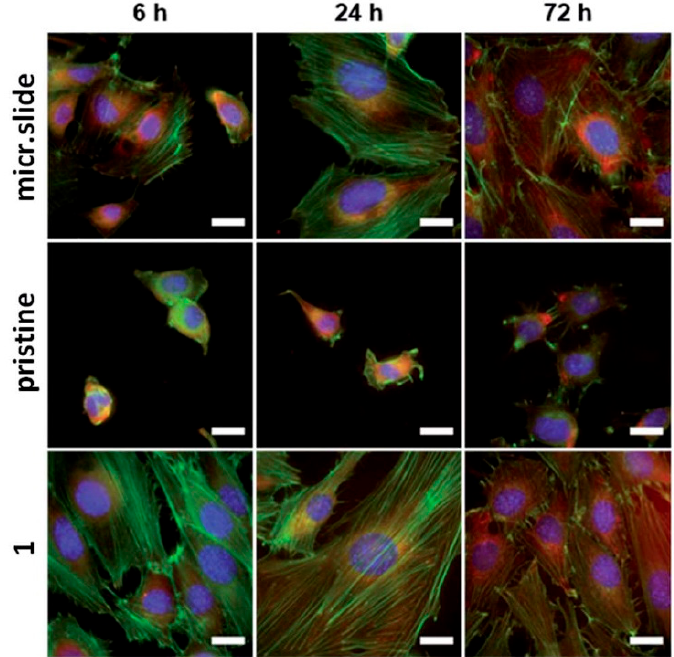
Figure 5. Immunofluorescence microscopy images of NIH 3T3 cells growing on a pristine polymer, control and plasma treated samples—1 (100 W, 240 s, O2/Ar), for 6, 24, and 72 h. F-actin of cell cytoskeleton in green (phalloidin-Atto 488), nucleus in blue (DAPI), and talin 1 was visualized by antibody labeled with Atto 647. The scale bar is equal to 20 μ m.